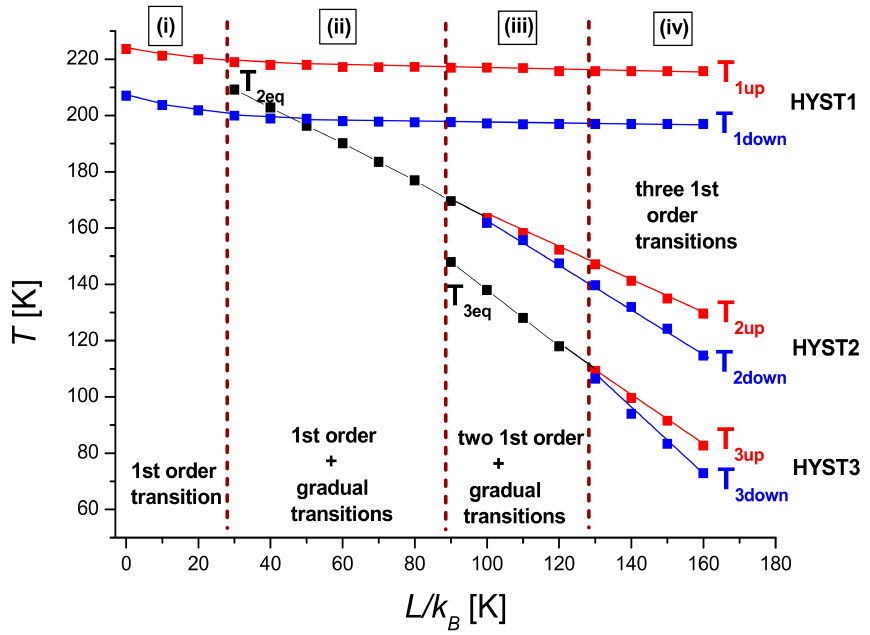
Figure 7. Phase diagram T = f ( L / k B ) for a 2D hexagonal-shaped system comprising 91 atoms (H6). The red and blue squares correspond, respectively, to the upper and lower transitions for the heating ( T up ) and cooling ( T down ) temperatures of the thermal HS fraction. The black squares correspond to the equilibrium temperatures ( T eq ) of the gradual transitions. The computational parameters were ∆ / k B = 1300 K, J / k B = 40 K, G / k B = 70 K, and ln( g ) =